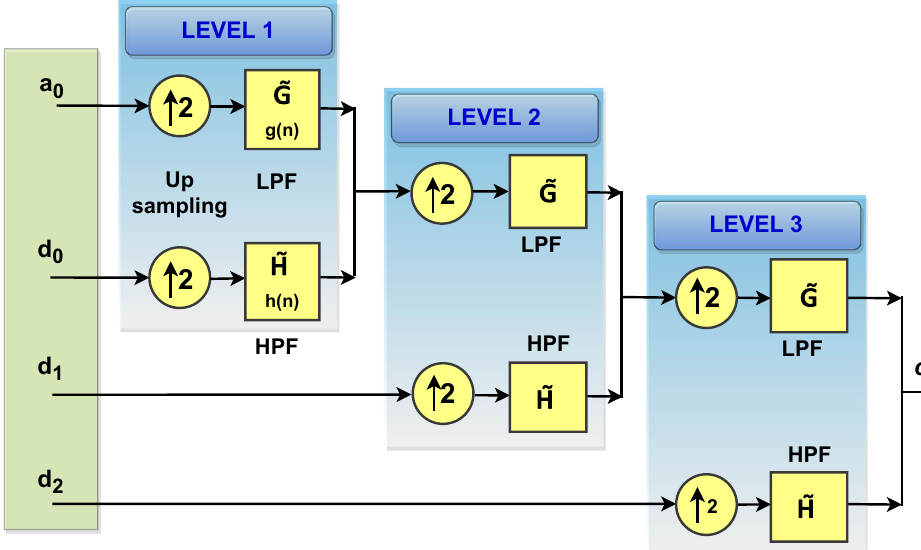
Figure 2. Three-level inverse discrete wavelet transform.